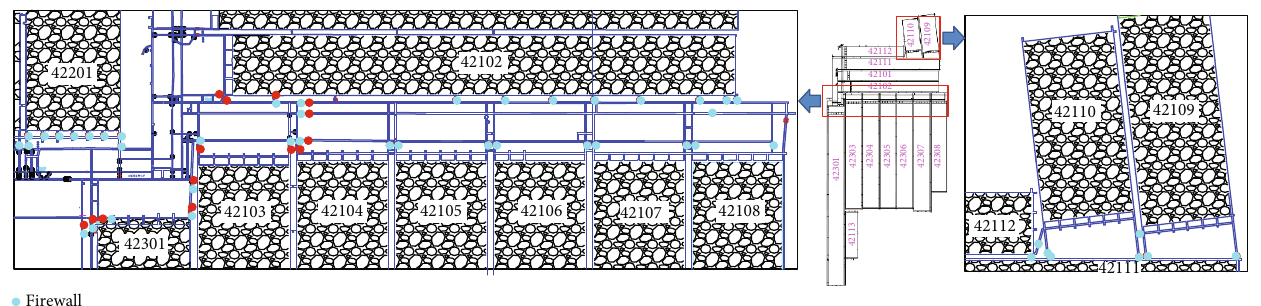
Figure 9: Map of fi rewalls and waterproof walls in the south and north wings of goafs in No.